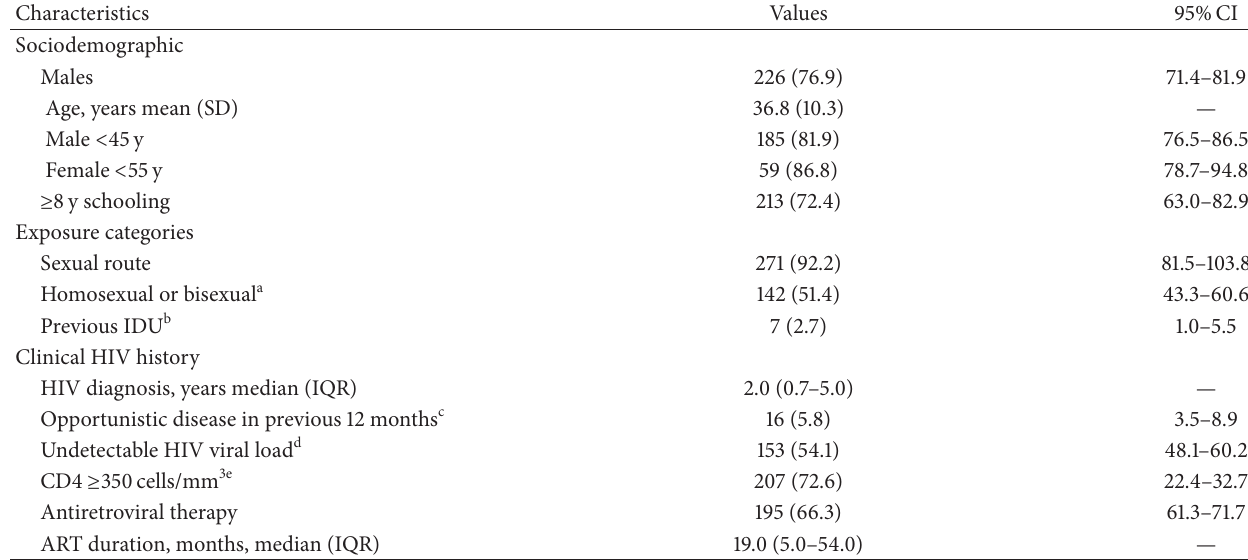
Table 1: Sociodemographic and clinical characteristics of 294 HIV-infected patients.